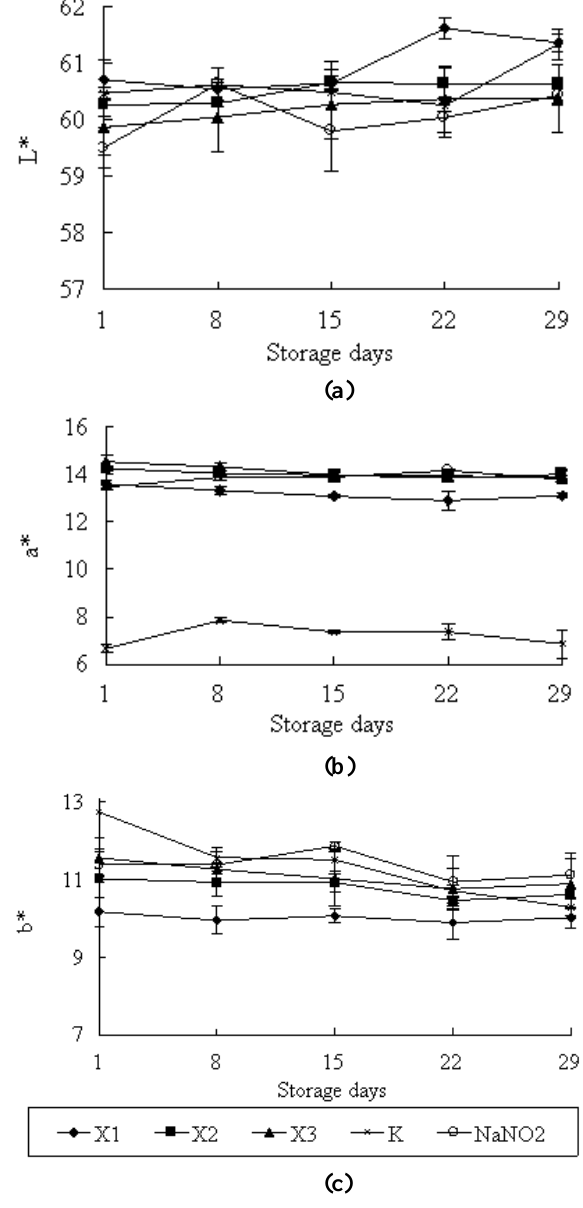
Figure 1. The changes in color of pork sausages. (a): The changes in L* of pork sausages; (b): The changes in a* of pork sausages; (c): The changes in b* of pork sausages. X1, X2 and X3 stand for the samples with 0.1%, 0.2% and 0.3% Amaranthus pigments addition, respectively; K stands for the controls, NaNO 2 stands for the samples with 0.015% NaNO 2